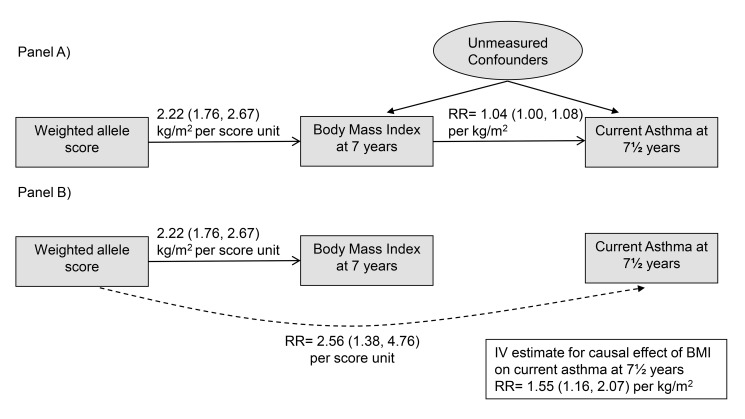
Main Mendelian randomization features and results of the study.(A) depicts the IV assumptions, and (B) shows the two unconfounded associations used to estimate causal effects of BMI on asthma: the association of the allele score with BMI and the association of the allele score with asthma.